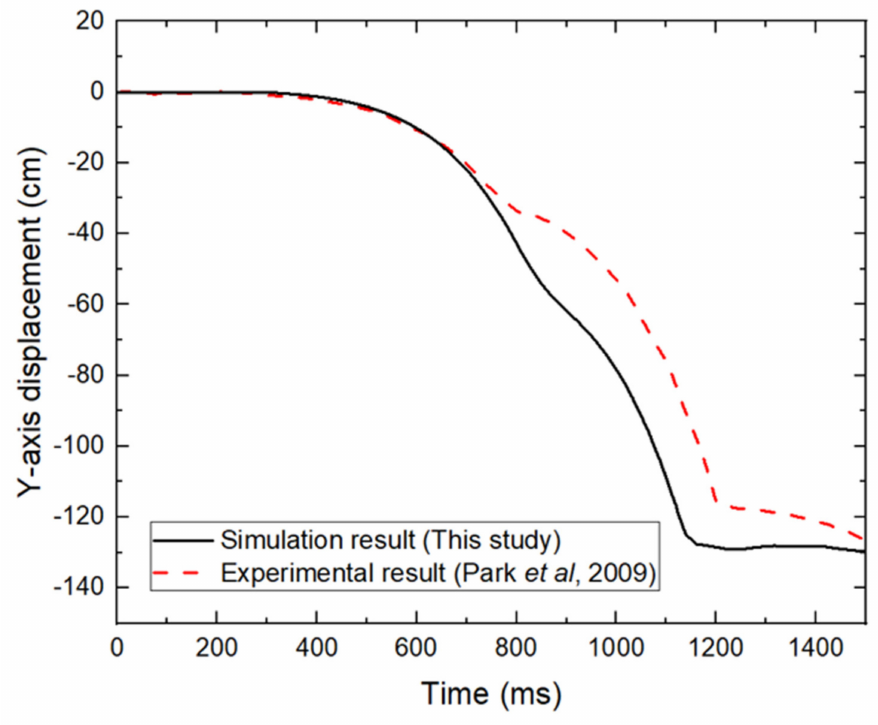
Figure 16. Comparison of the y-axis displacement in experiment and numerical simulation (This figure has been reproduced from [7] under the terms and conditions of the CC BY-NC